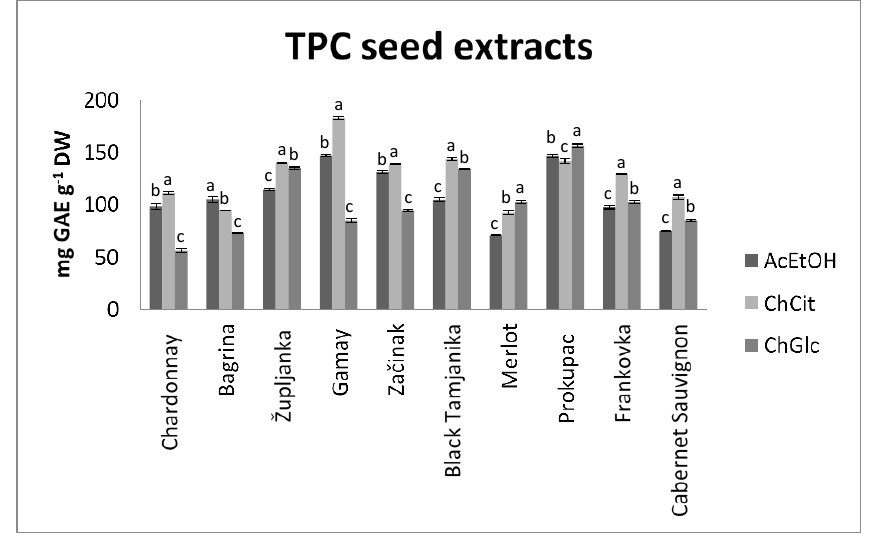
Figure 1. Total polyphenol content of seed extracts obtained from ten grape varieties. Data are expressed as mg GAE g −1 DW for each variety, means ± SD, n = 3. Different lower case letters (a-c) indicate significant differences among solvents ( p ≤ 0.05) based on post hoc Tukey’s test.